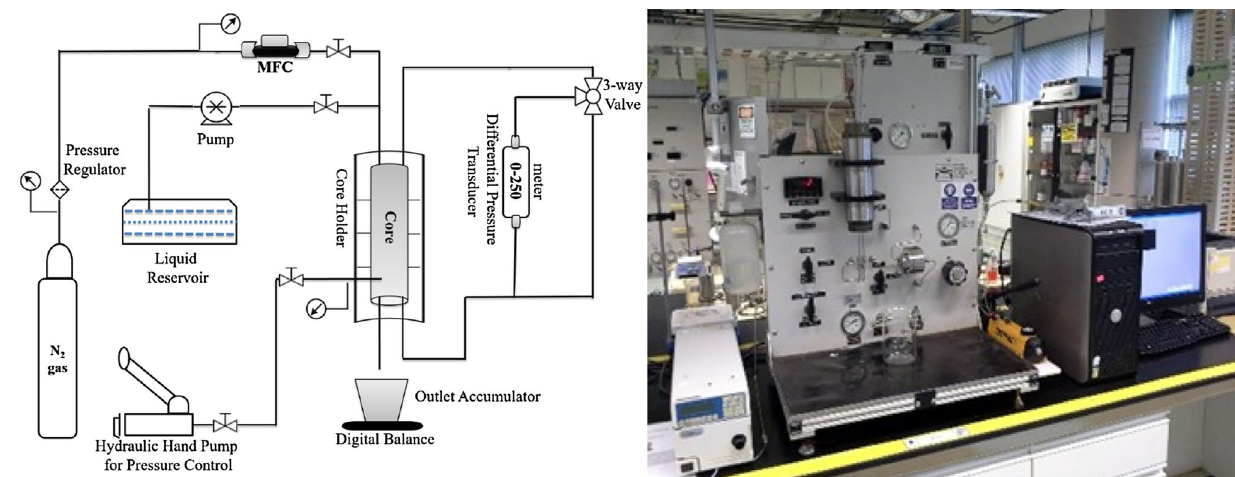
Fig. 3 Schematic and snapshot of BPS-805 coreflooding